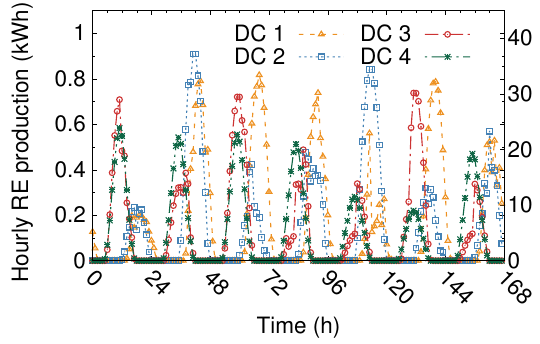
Figure 5. Production of RE in each considered DC